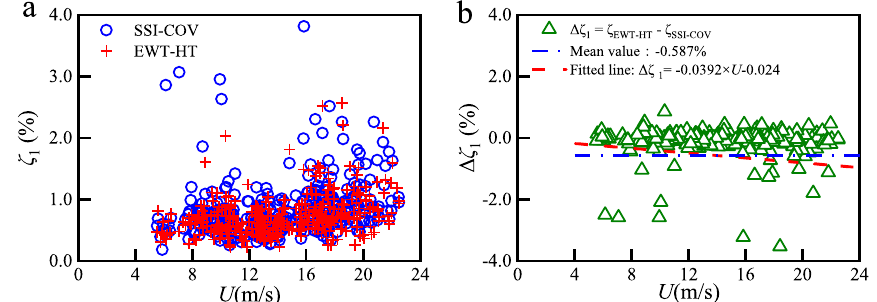
Fig. 15 Measured modal damping ratio of first-order vertical bending of PSRB: a Two identification methods; b Difference between two identification methods